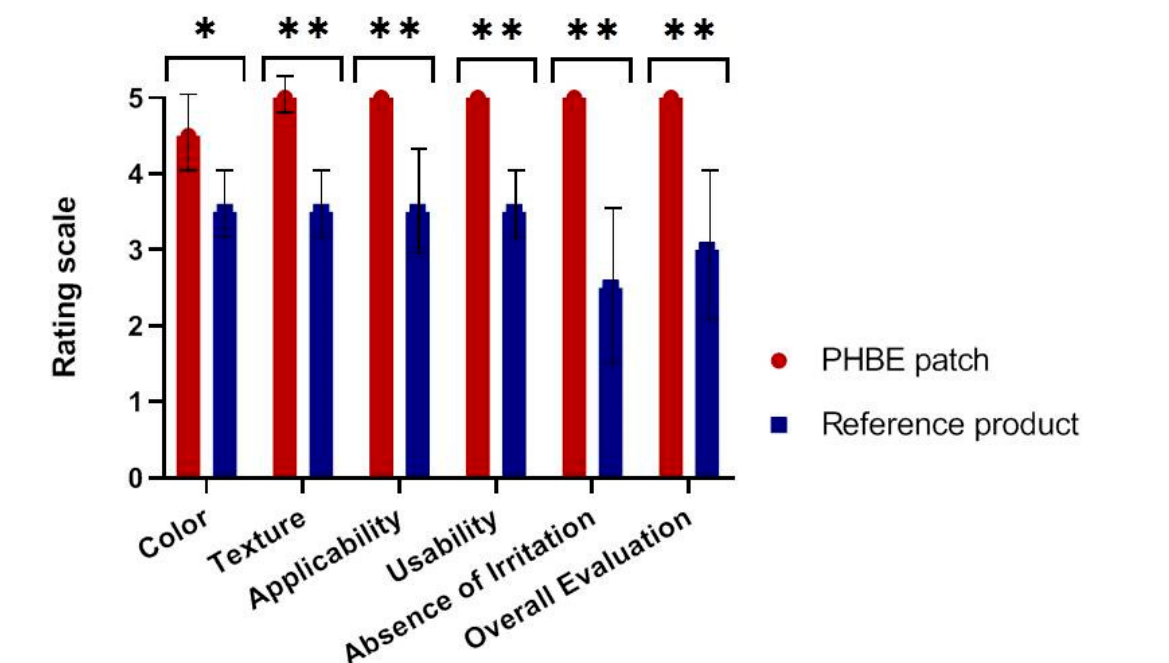
Figure 9. Patients’ evaluation of the two interventions (PHBE patch and reference cream) based on their main characteristics (color, texture, applicability, ease of use, absence of irritation, and overall evaluation). Significant differences were observed between the two interventions (* p < 0.05, ** p < 0.01), with patients preferring the PHBE patch over the reference cream.